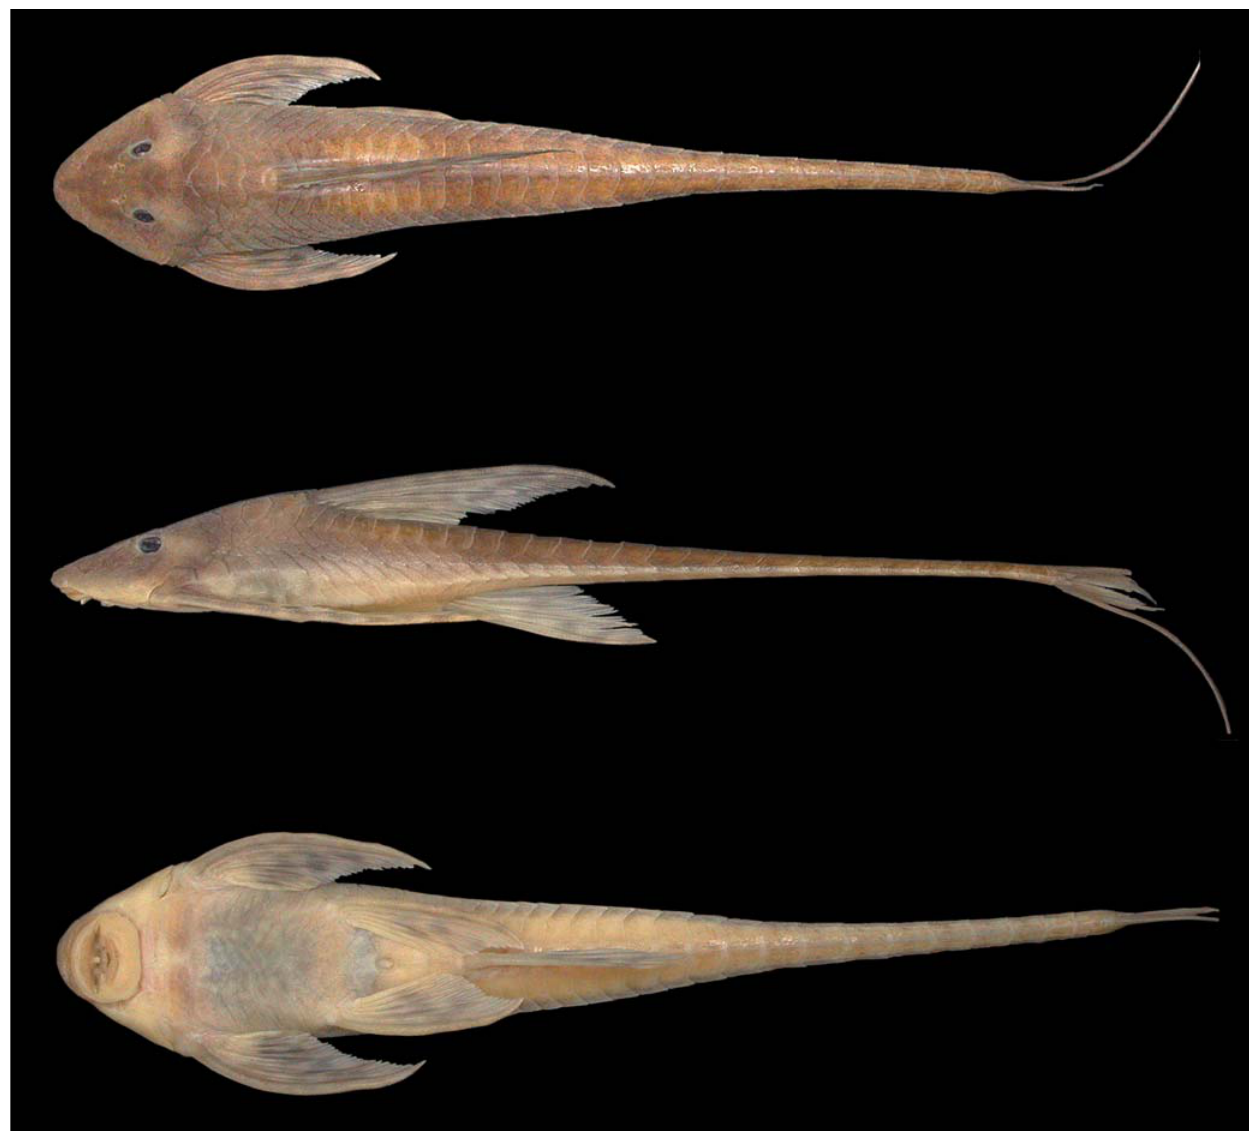
Fig. 12. Lamontichthys maracaibero , INHS 35473, 131.3 mm SL. Dorsal, lateral and ventral